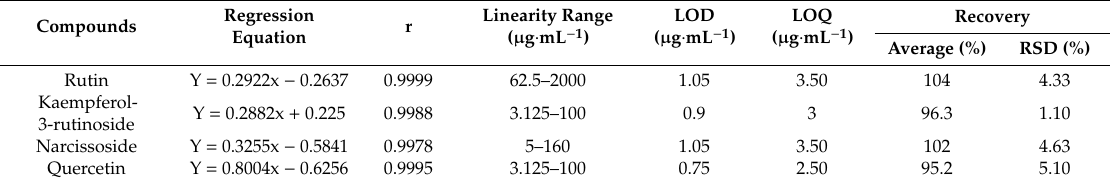
Table 4. The calibration curves, linearity ranges, LODs (limits of detection), LOQs (limits of quantification), and recoveries of four compounds ( n = 6).